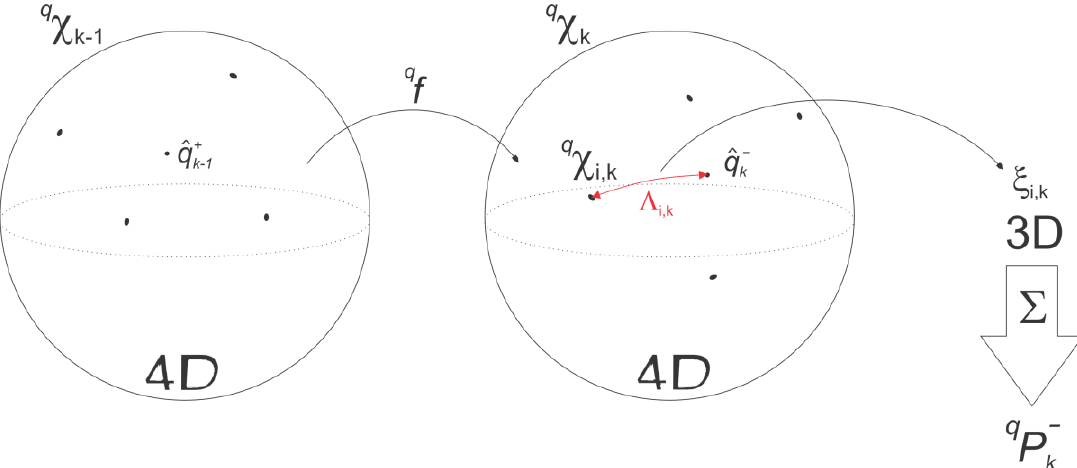
Figure 4. Schematic diagram of the rotational part of the UKF